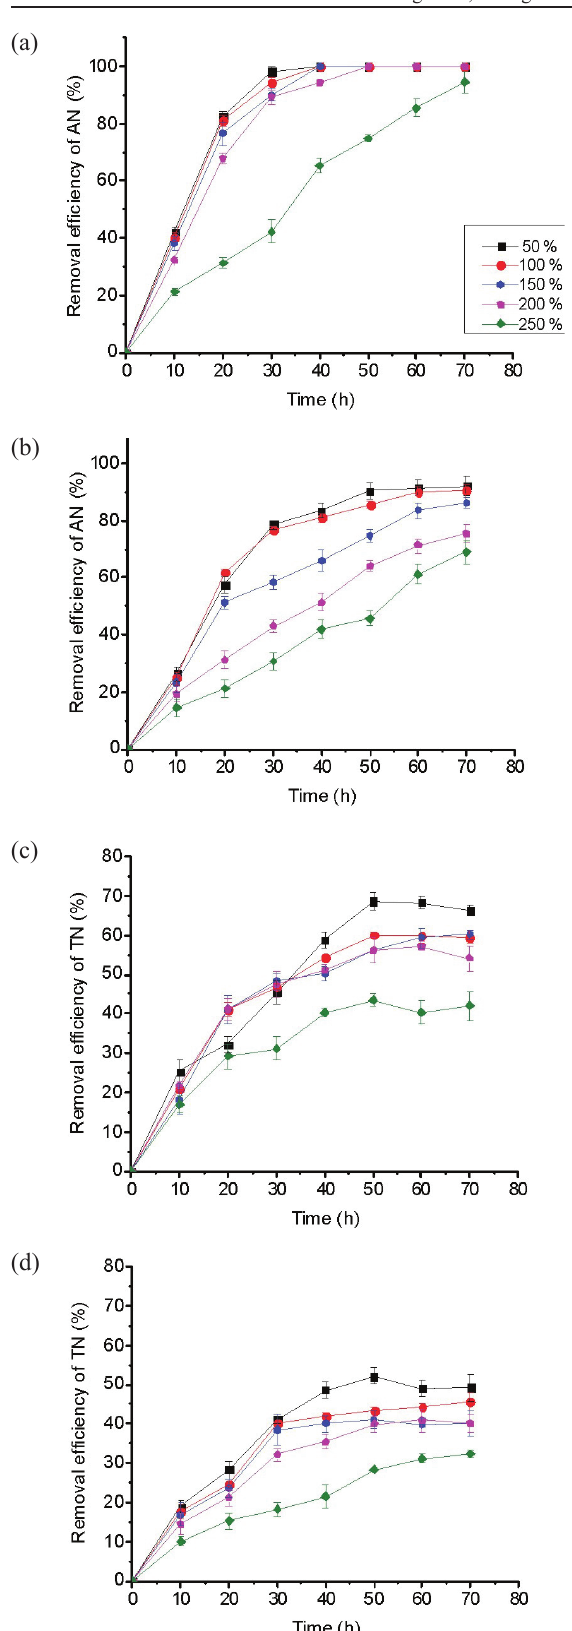
Fig. 8 – Effect of wastewater concentration on AN removal by immobilized microorganism (a) and free microorganism (b) and effect of wastewater concentration on TN removal by im- mobilized microorganism (c) and free microorganism (d)